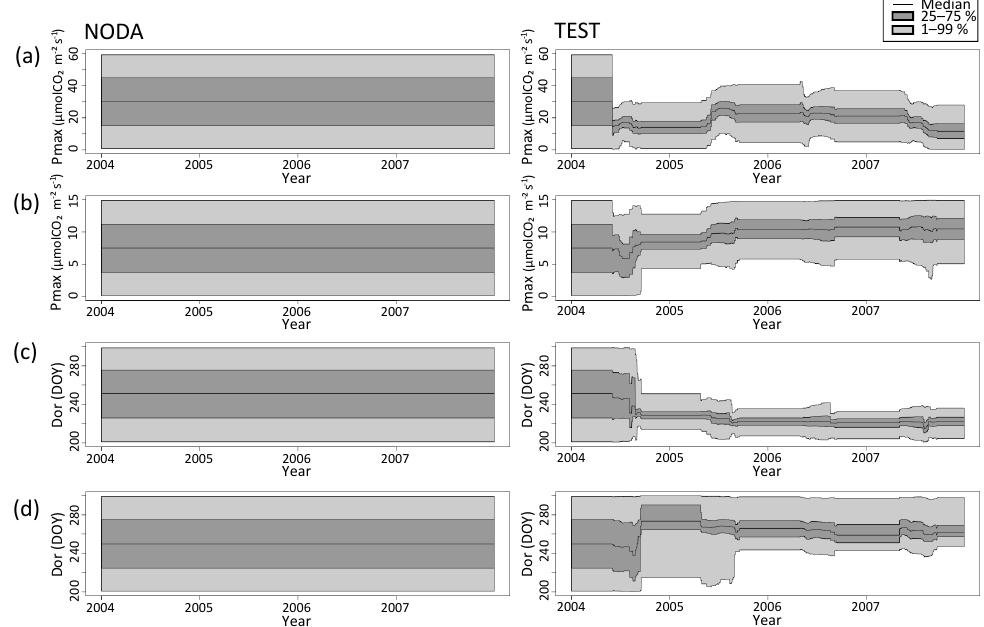
Figure 8. Similar to Fig. 4, showing the model parameters: (a) Pmax for tree, (b) Pmax for grass, (c) Dor for tree, and (d) Dor for grass but for the real-world